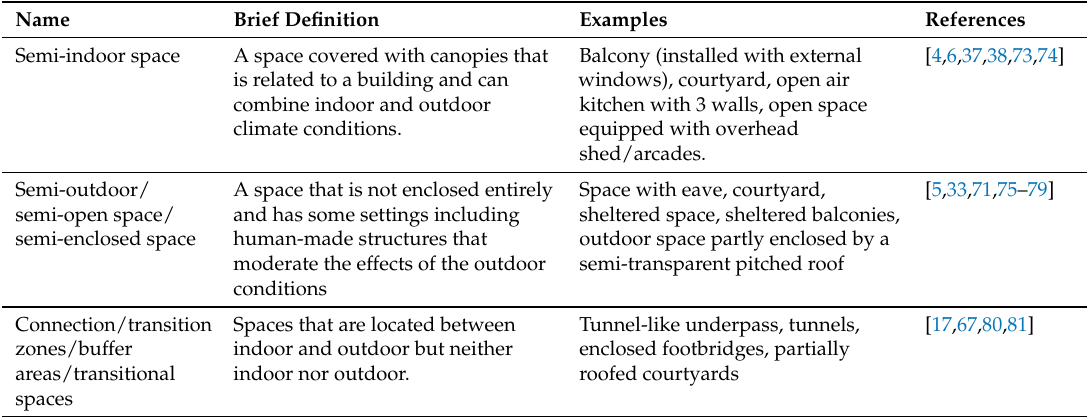
Table 2. Classifications and definitions of spaces between indoor and outdoor in the field of building micro-climate and thermal